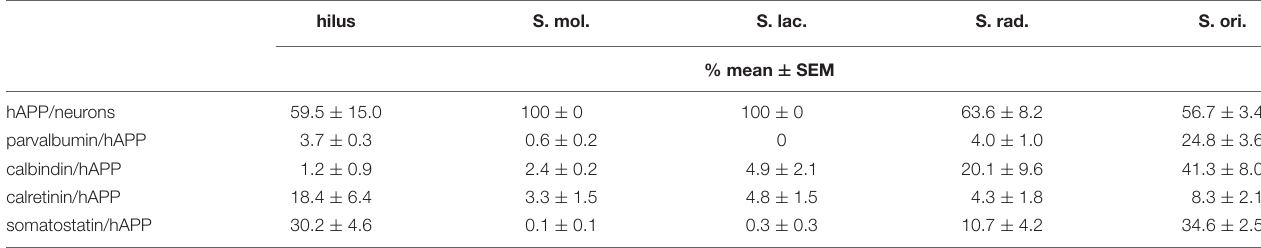
TABLE 1 | Proportions of hAPP-positive neurons in hippocampal layers and proportions of hAPP-positive neurons expressing parvalbumin, calbindin, calretinin, and somatostatin.